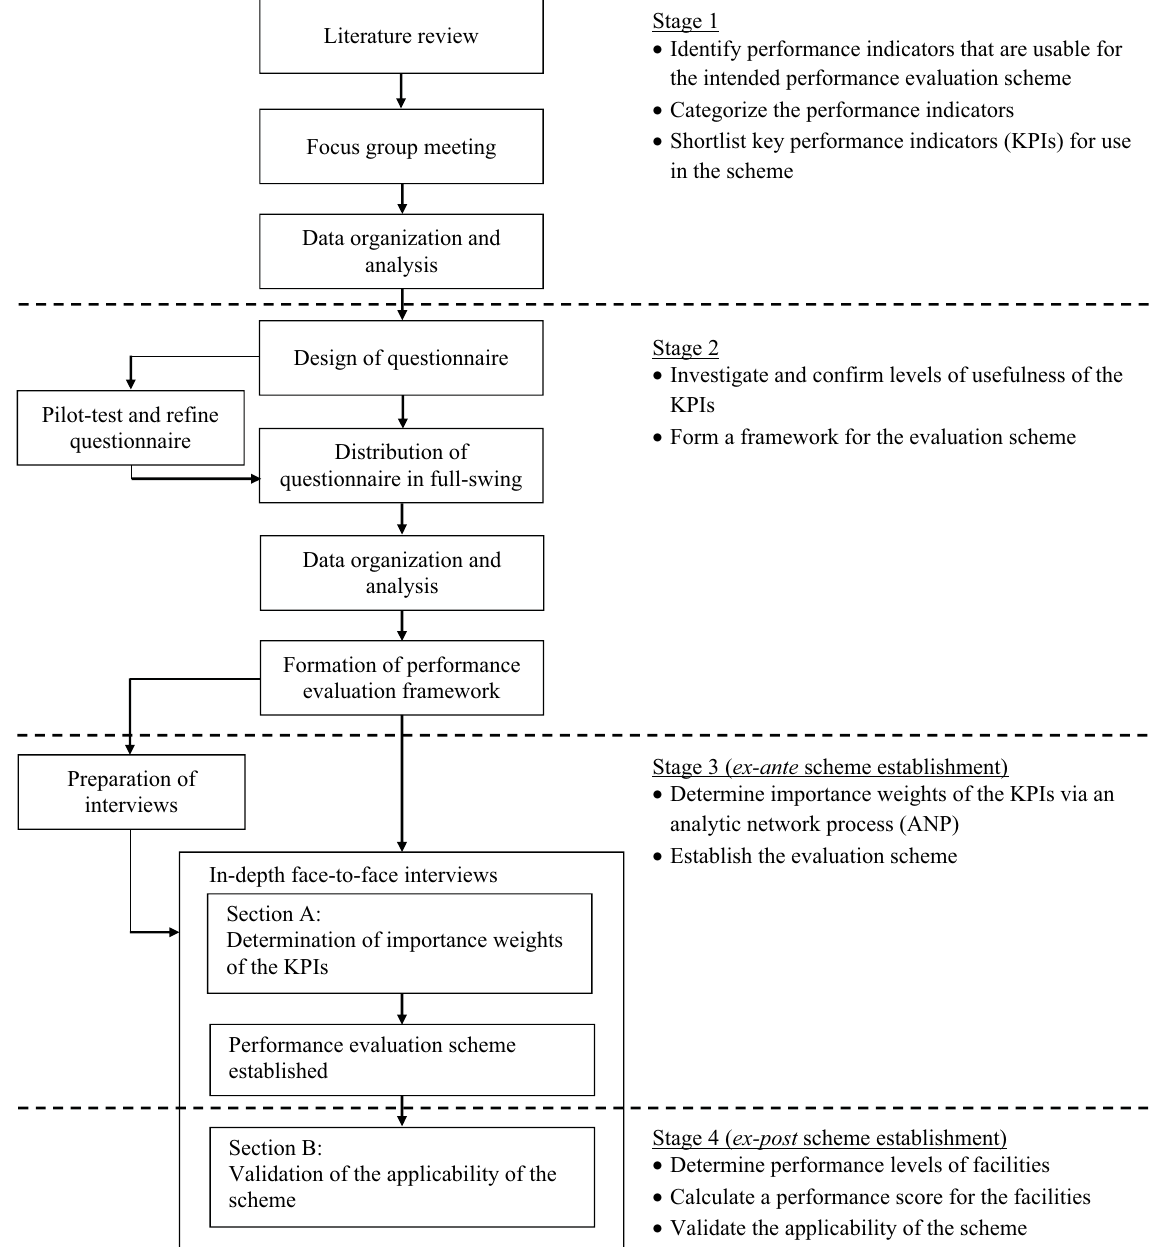
Fig. 1. Overall research process of the